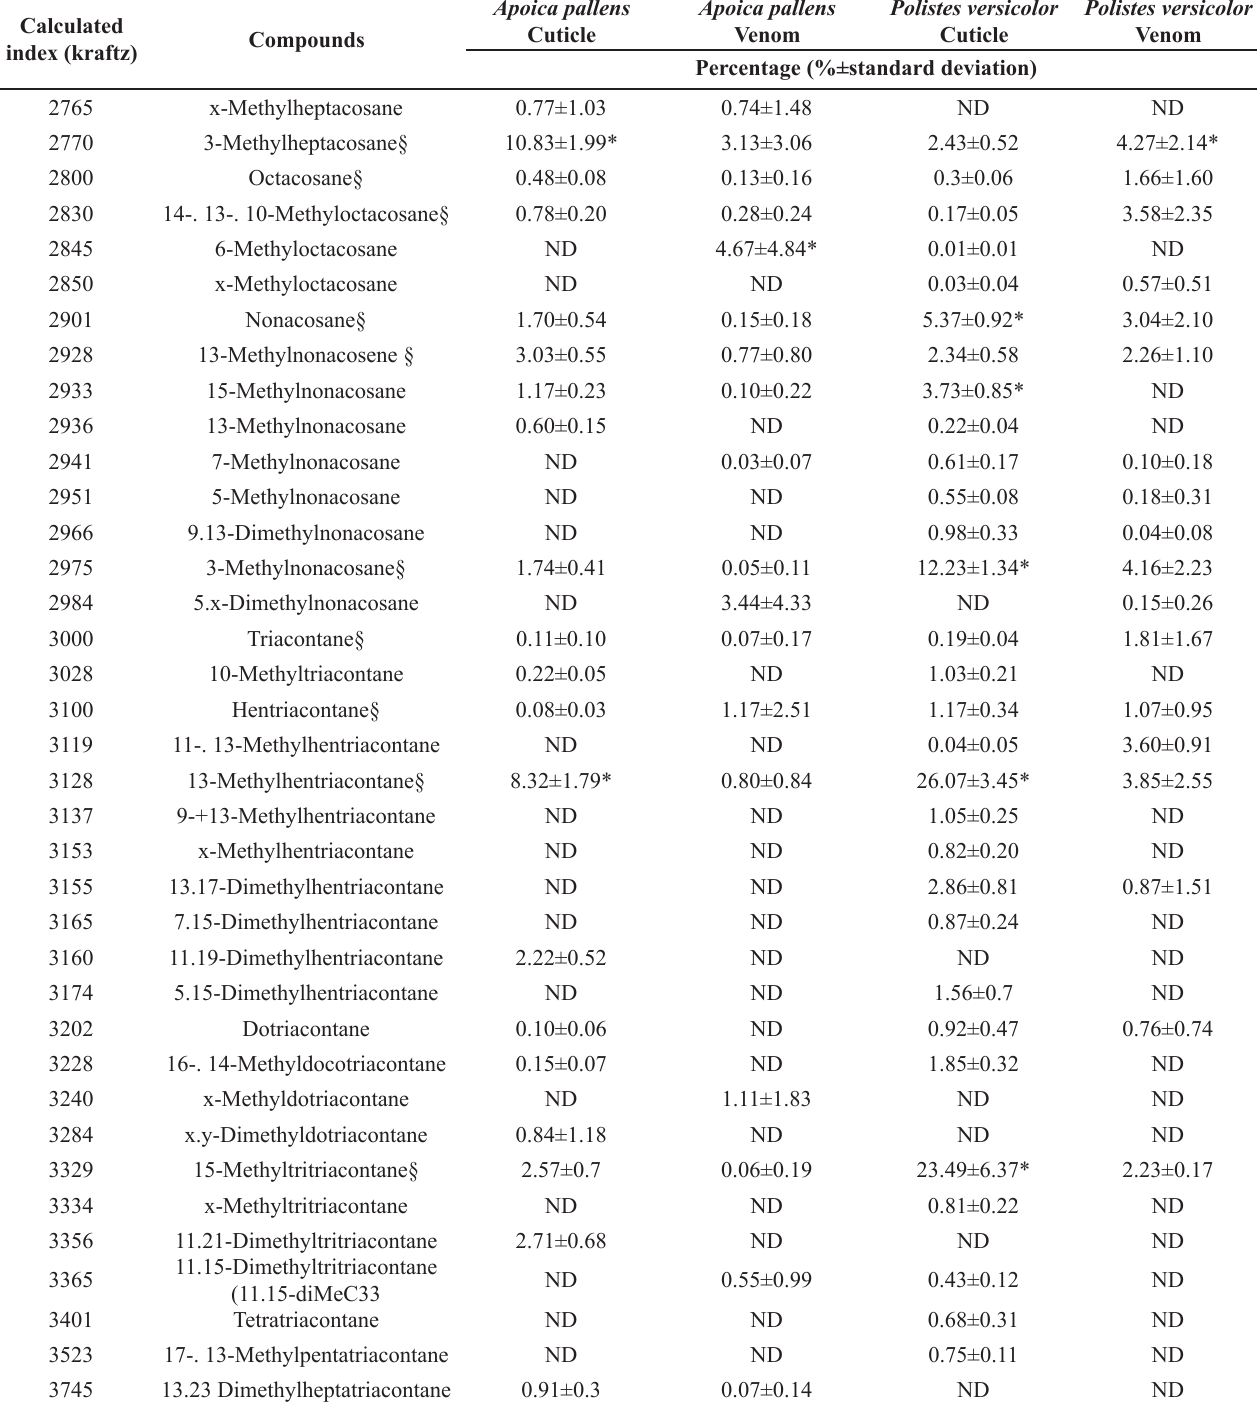
Table 1. Percentage area of nonpolar compounds (> 0.5%) present in cuticle and venom of eusocial wasps Apoica pallens and Polistes versicolor .